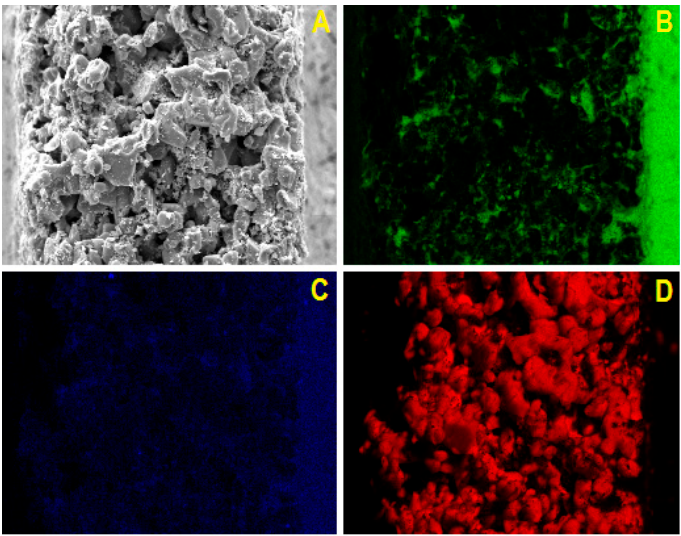
Figure 3. SEM image ( A; 2000× enlargement) and EDX analysis (( B ) Ce; ( C ) Ni; ( D ) Si) of 10 Ni monolith.